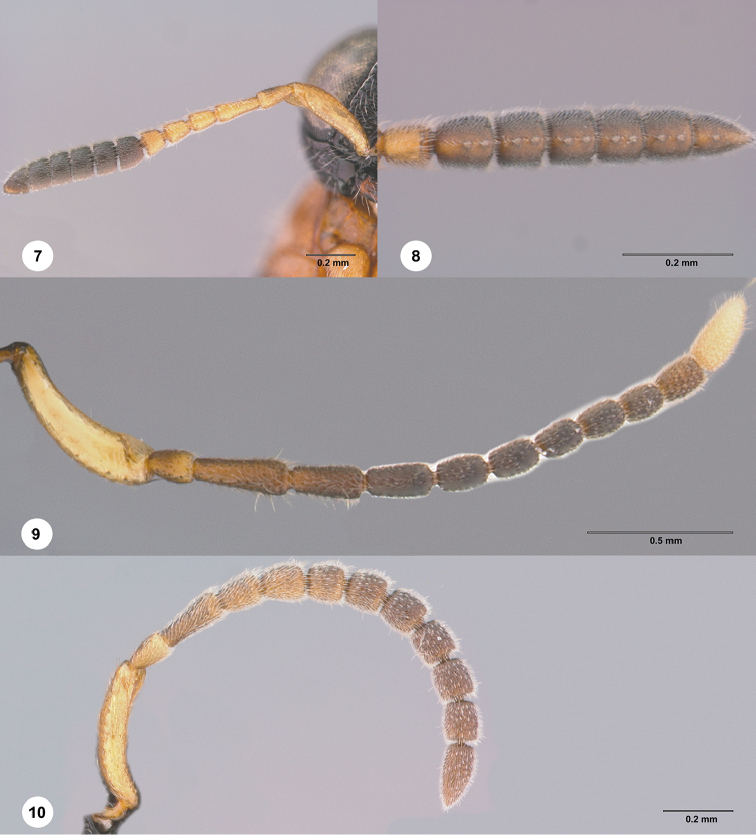
7–8Chromoteleiarara sp. n., female, holotype (OSUC577495). 7 Antenna 8 Antennal clava, ventral view 9Chromoteleiaingens sp. n., paratype, male (OSUC583458) Antenna 10Chromoteleiabidens sp. n., paratype, male (OSUC185675) Antenna.